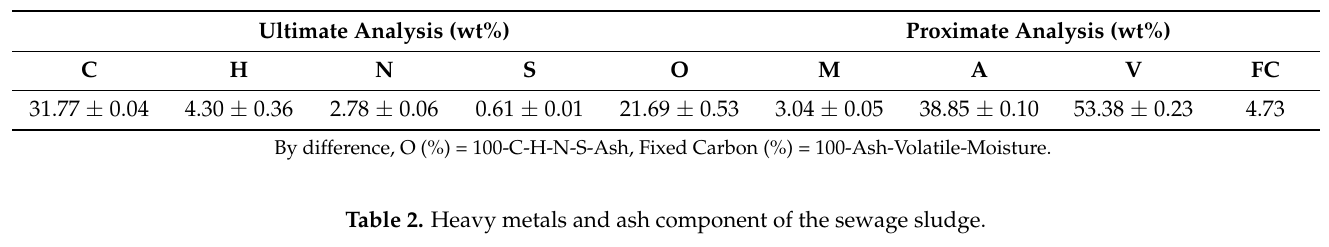
Table 2. Heavy metals and ash component of the sewage sludge.